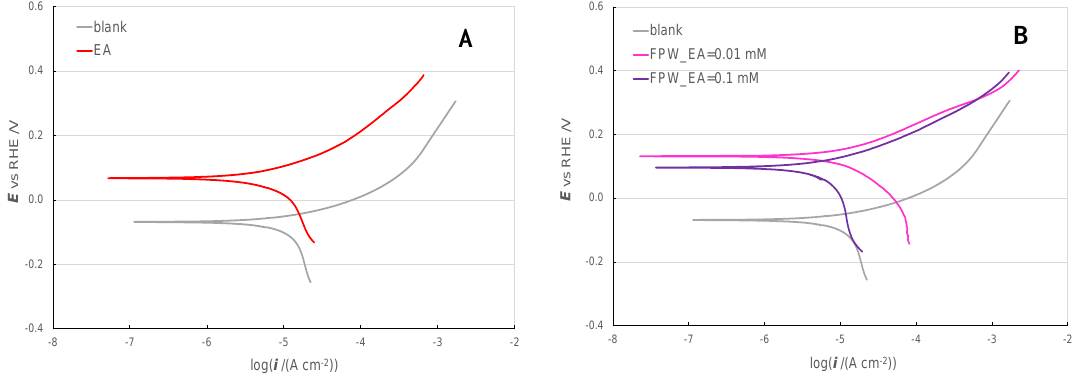
Figure 4. Potentiodynamic polarization curves (scan rate 0.5 mV s − 1 ) of Armco ® iron electrodes in aerated 0.05 M NaCl with 1 vol% methanol (grey lines). ( A ): with the addition of 10 µM ellagic acid (red line); ( B ): with different concentrations of FPW extract. Electrolyte temperature: 30 °C.